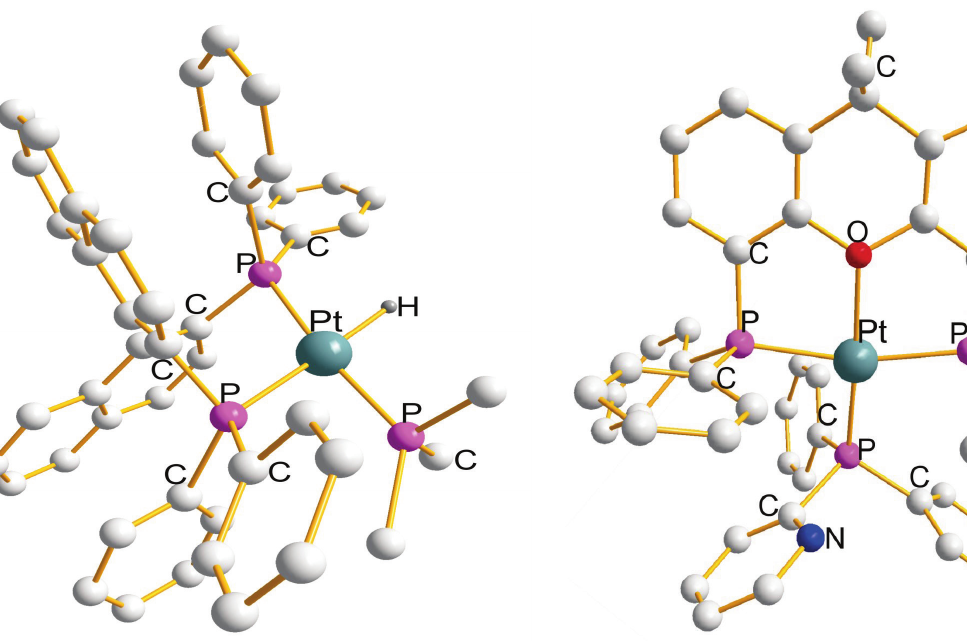
P(C H )PPh }(PMe )(H)] + (Campbell 2 20 12 2 3